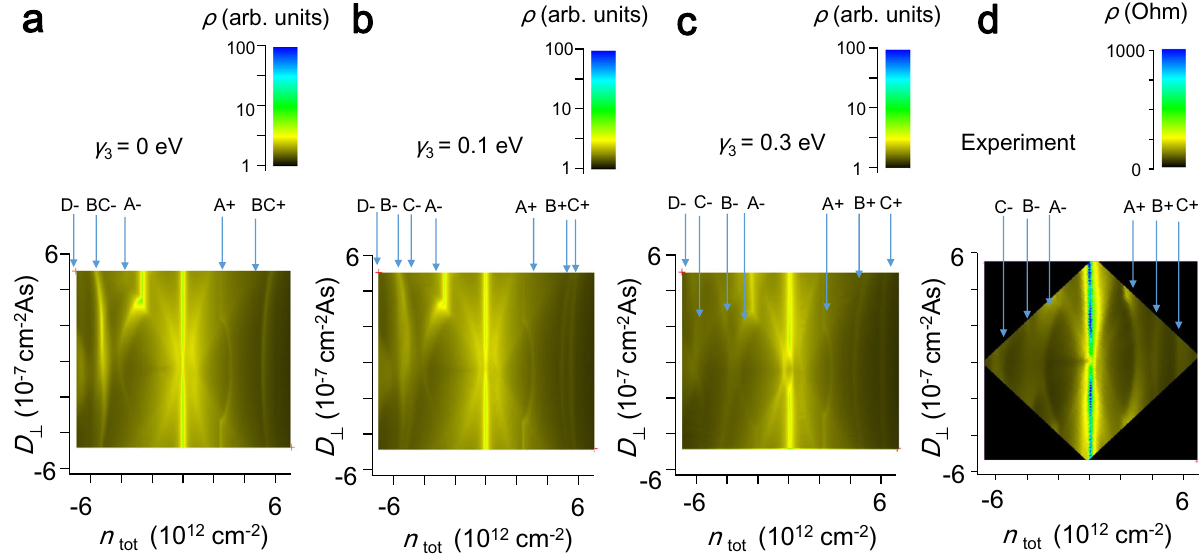
= 0 eV, b γ = 0.1 eV, and c γ = 0.3 eV. Panel d shows 3 3 3